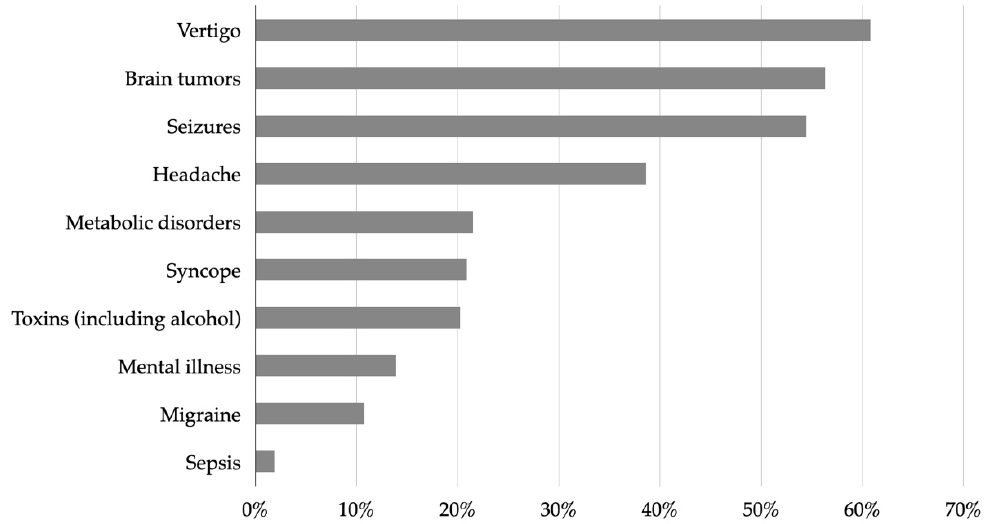
Figure 5. Conditions that were reported by the EMS staff as the most common stroke